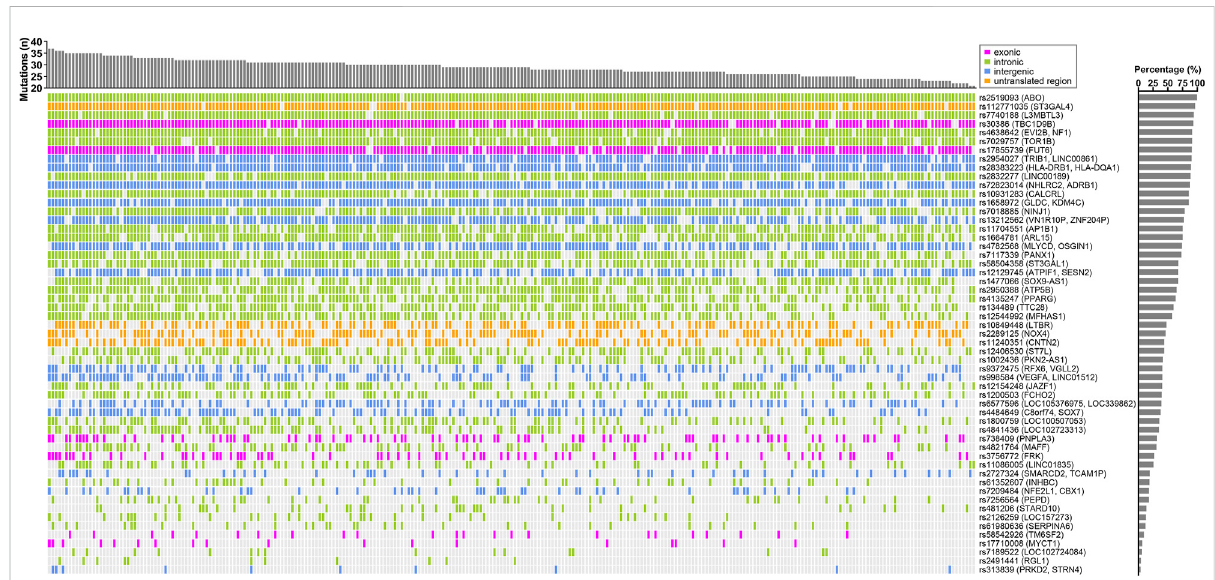
FIGURE 2 Landscape of ALT-associated variants in CCHC subjects with elevated ALT levels. The bar chart at the top represent the number of variants in each subject. The bar chart on the right shows the frequency of each variant in those CCHC subjects with elevated ALT levels. Each column represents one subject and each row represents one variant.